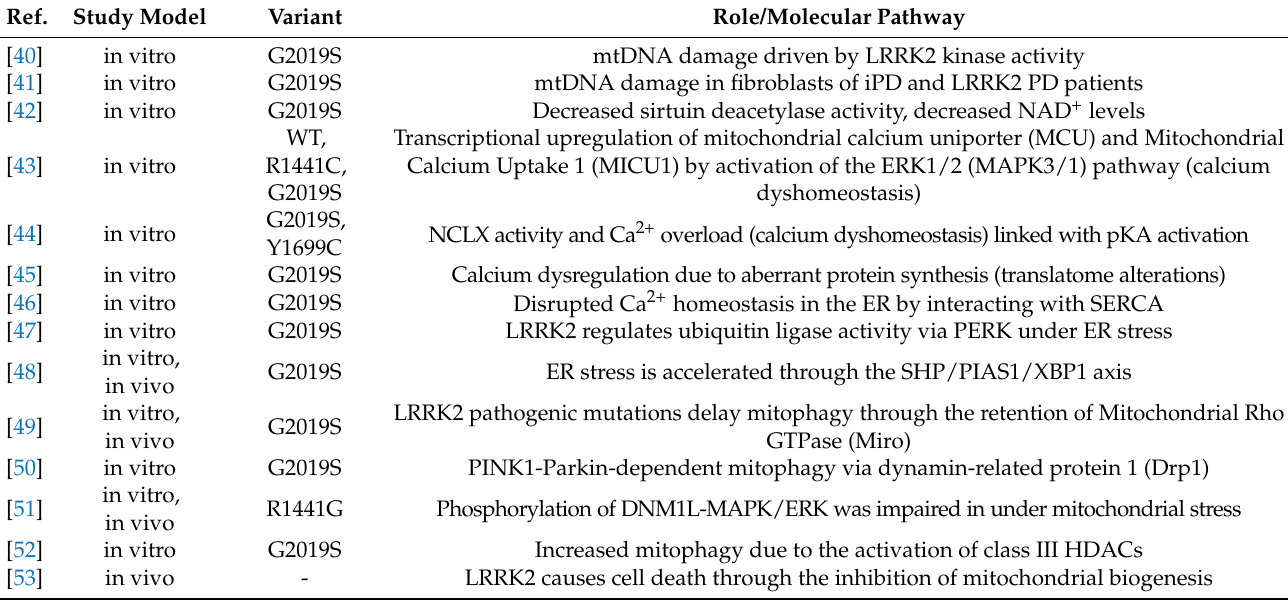
Table 5. Studies exploring the relationship of LRRK2, mitochondrial dysfunction, and ER